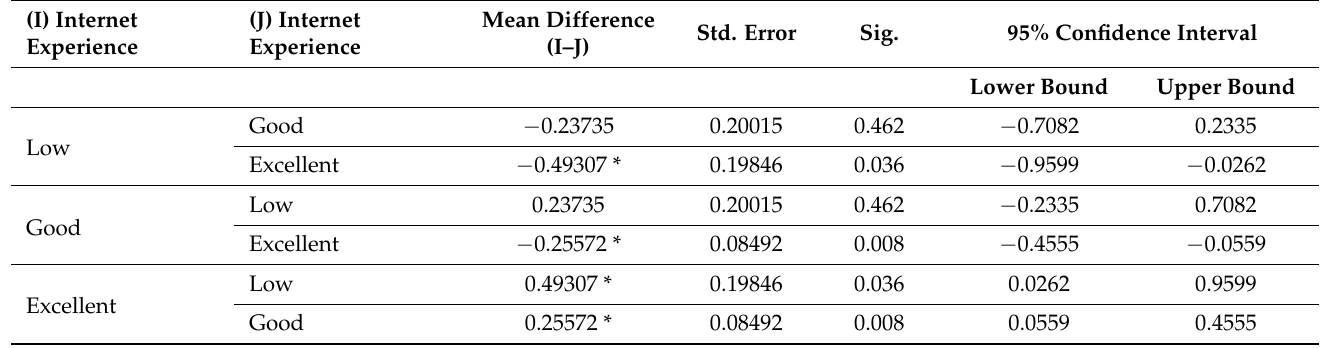
Table 12. Multiple comparisons analysis of the behavioral intention attributed to Internet